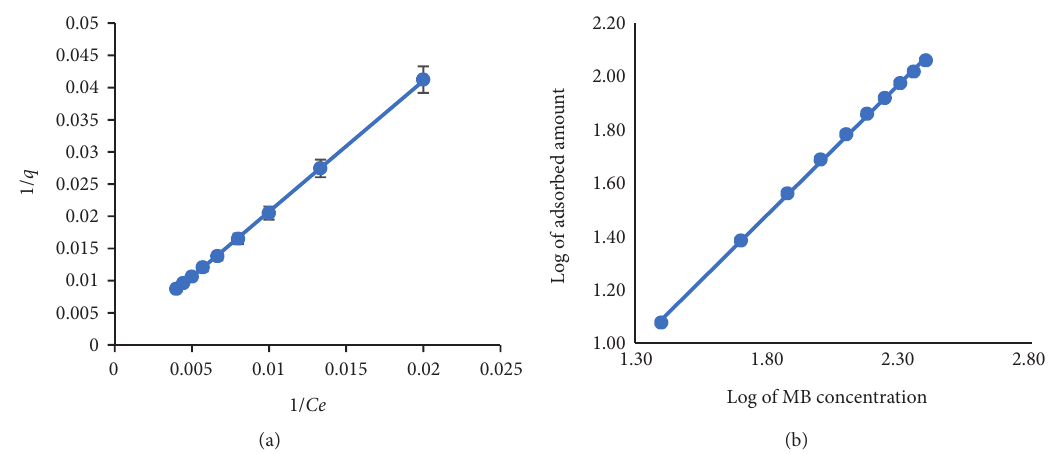
Figure 4: Sorption isotherms: Langmuir (a) and Freundlich (b) for nance seeds at pH 7.